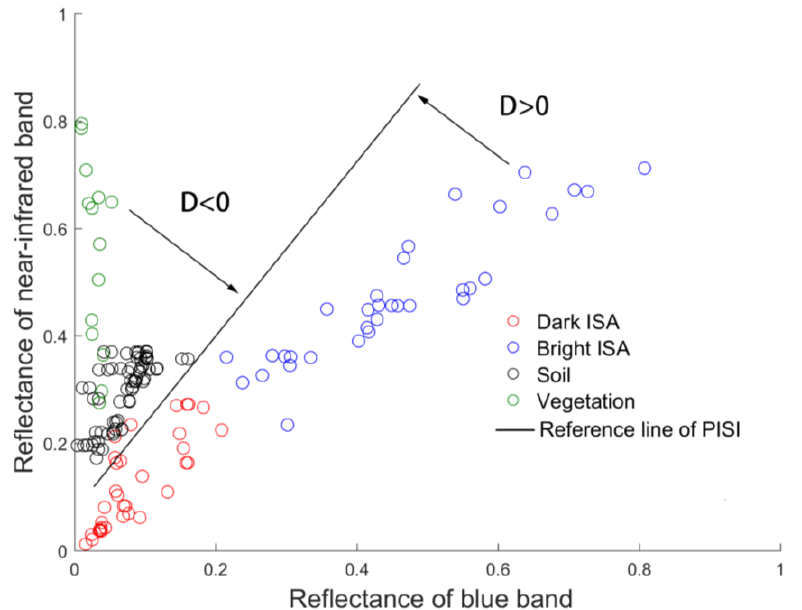
Figure 4. PISI reference line and sample distance to this line. The distance in the area above the reference line is negative, and below the reference line is positive.